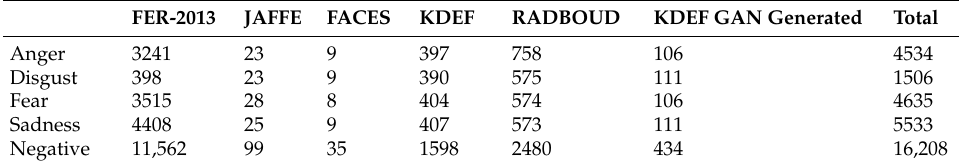
Table 3. Training data for negative class (Model B).